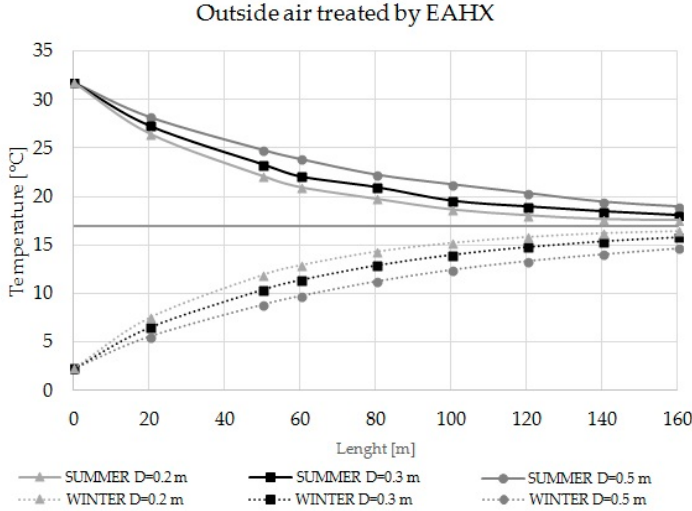
Figure 8. Air temperature at the outlet of the EAHX as a function of tube length for three different inner tube diameters in summer and winter.